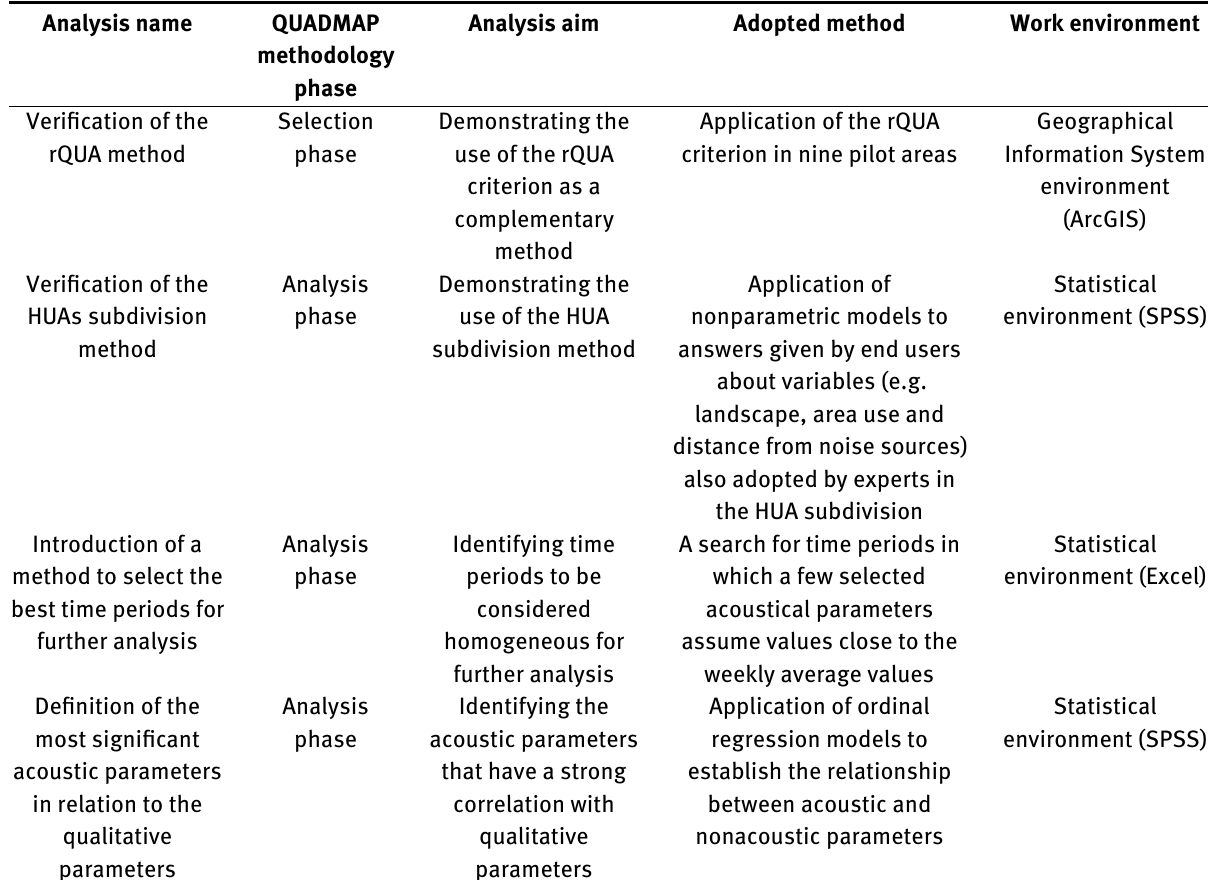
Table 1: Synthesis of analyses on achieved